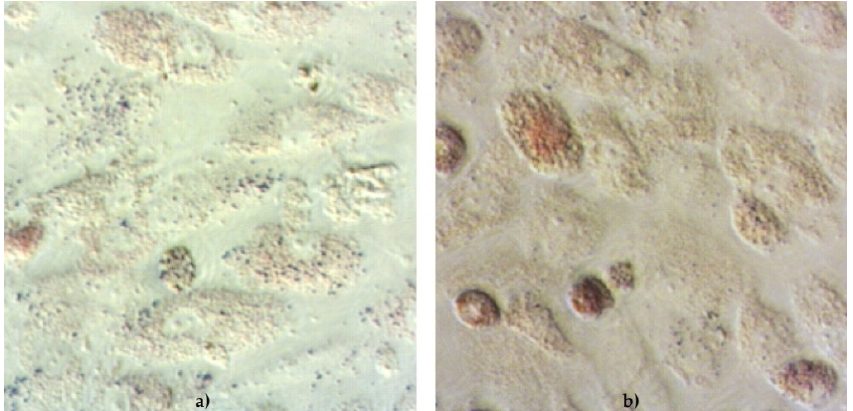
Figure 1. Functionality of canine adipose-derived mesenchymal stem cells (cAD-MSCs) demon- strated by successful differentiation into adipocytes. Microscopic images (40×) of cAD-MSCs after adipodifferentiation stained with Oil O Red for detection of lipid droplets within cell. Cells cultivated for 21 days in basal medium (negative control) ( a ) and stained with Oil O Red, showing lack of red staining. cAD-MSCs cultivated for 21 days in StemMACS AdipoDiff Media ( b ) successfully differentiated into adipocytes. When stained with Oil O Red, accumulated lipid droplets show high-intensity red staining within cell.